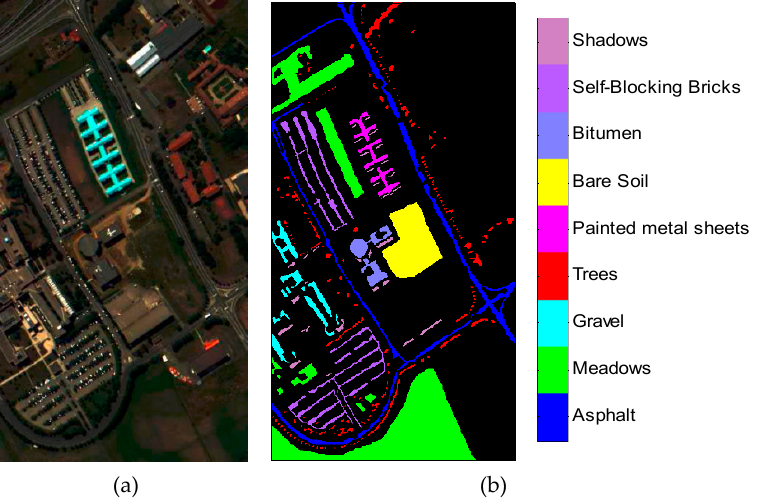
Figure 5. ( a ) False-color image of the Pavia University data, and ( b ) Ground truth of the Pavia Figure 5. (a) False-color image of the Pavia University data, and (b) Ground truth of the Pavia University University data.